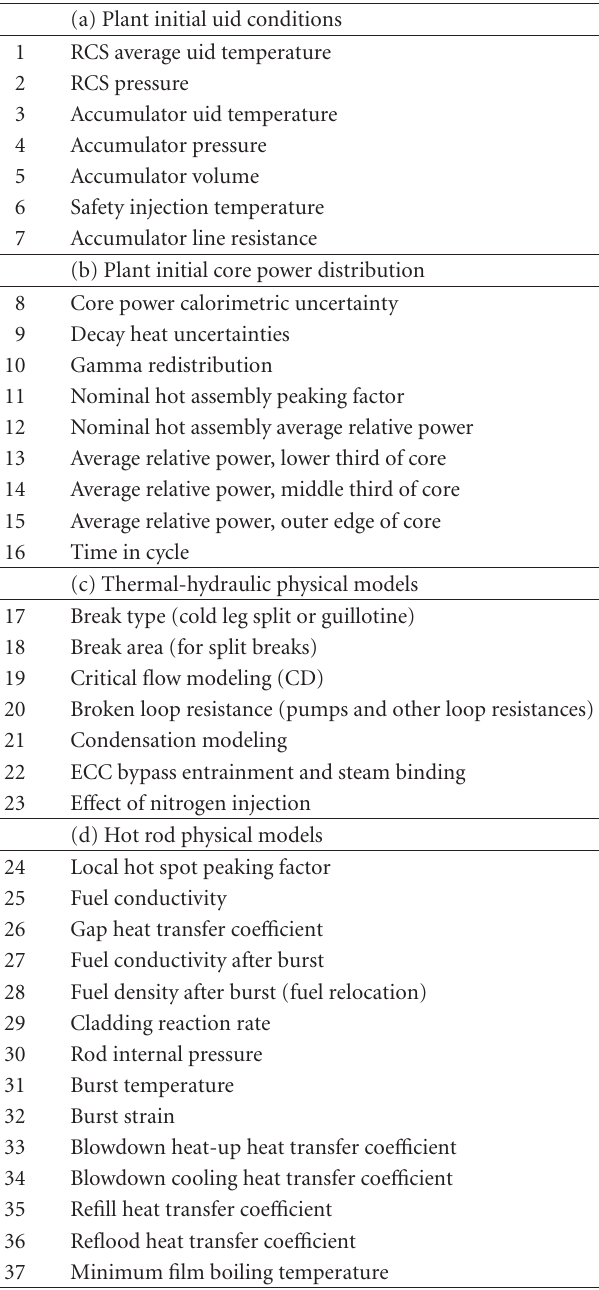
Table 1: PWR uncertainty